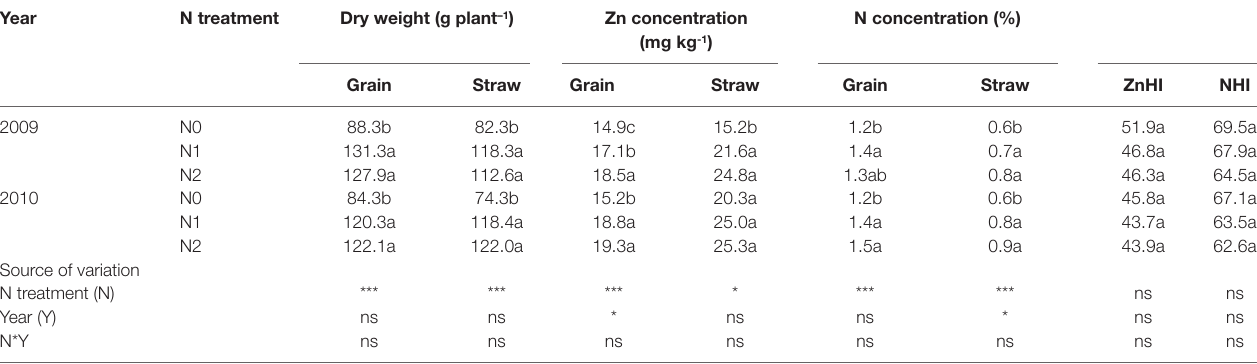
TABLE 1 | Dry weight of grain and straw, Zn and N concentrations of grain and straw, and grain Zn (ZnHI) and N (NHI) harvest index of summer maize as affected by N application rates in 2009 and 2010, respectively, in the field. Year N